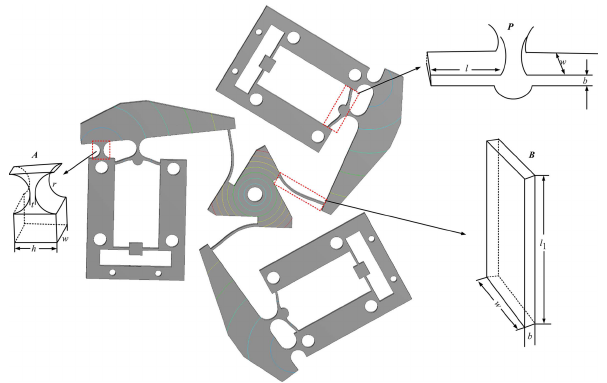
Figure 8. The motion simulation of manipulation stage with the condition of maximum input